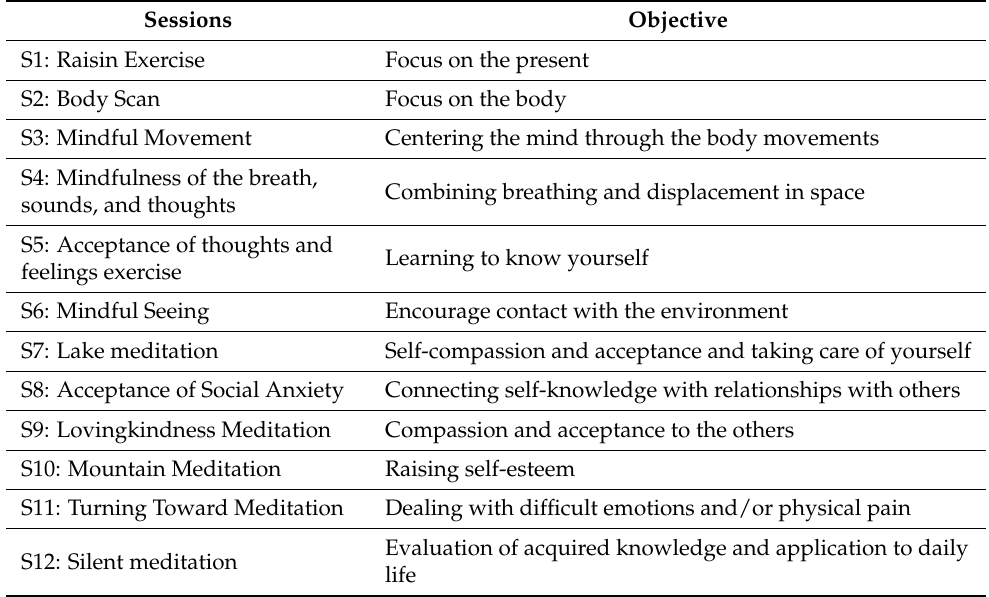
Table 1. Mindfulness and acceptance-based intervention program